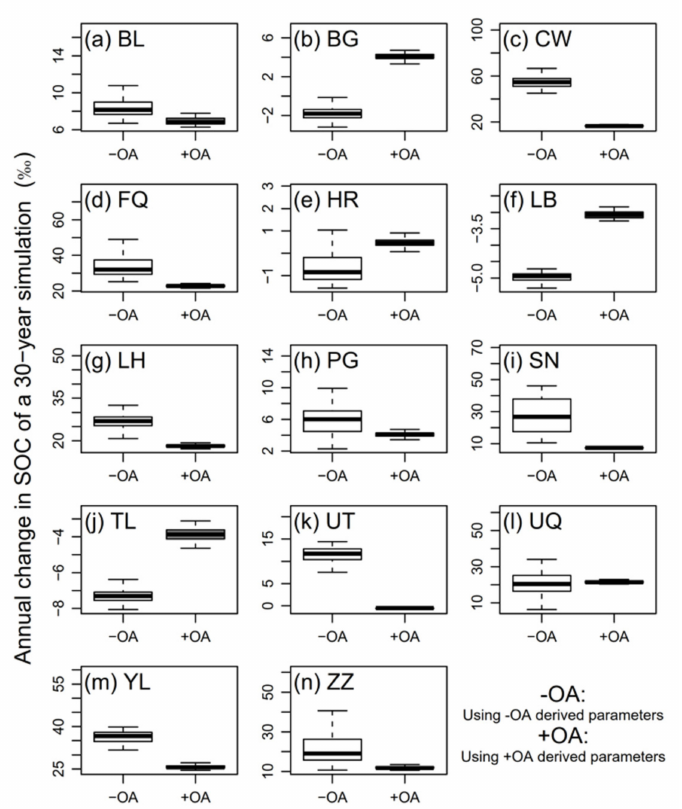
Figure 7. Relative changes of SOC stock in the last year of simulation to that in the first year under +OA treatment predicted using parameters derived from the two OA treatments (i.e., − OA- and +OA-derived parameters, respectively). At each site, the only difference for the two simulations is the use of different parameter ensembles derived from the two OA treatments. Boxplots show the median and interquartile range of 100 simulations using the 100 optimized model parameter ensembles for each OA treatment, with whiskers extending to the most extreme data point within 1.5 × (75–25%) data range. − OA, without or with less organic amendment; +OA, with or with more organic amendment. See Table 1 for the site